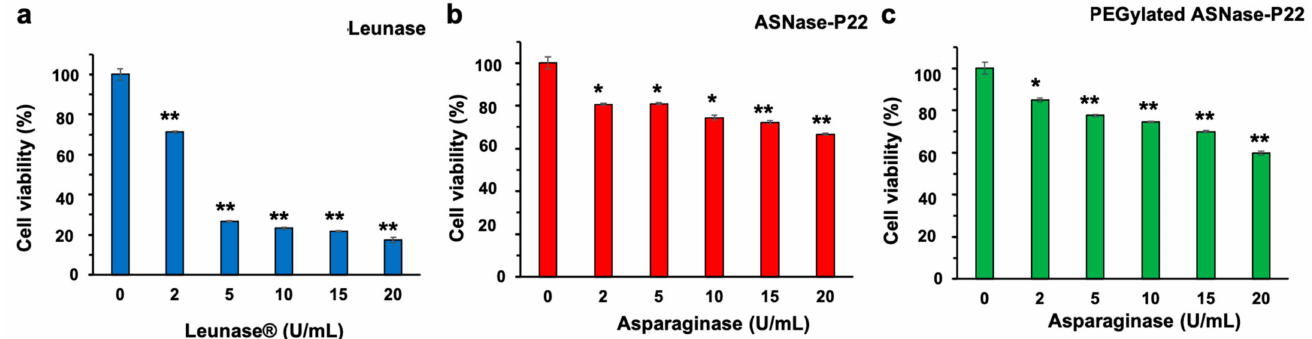
Figure 8. Concentration-dependent cytotoxicity of ASNase-P22 nanoreactors against MOLT-4 cells. ( a ) Control (+) Leunase ® ; ( b ) non-PEGylated; and ( c ) PEGylated ASNase-P22 nanoreactors. ( n = 3). Error bars represent the standard deviation. (*) p < 0.05, (**) p < 0.01.